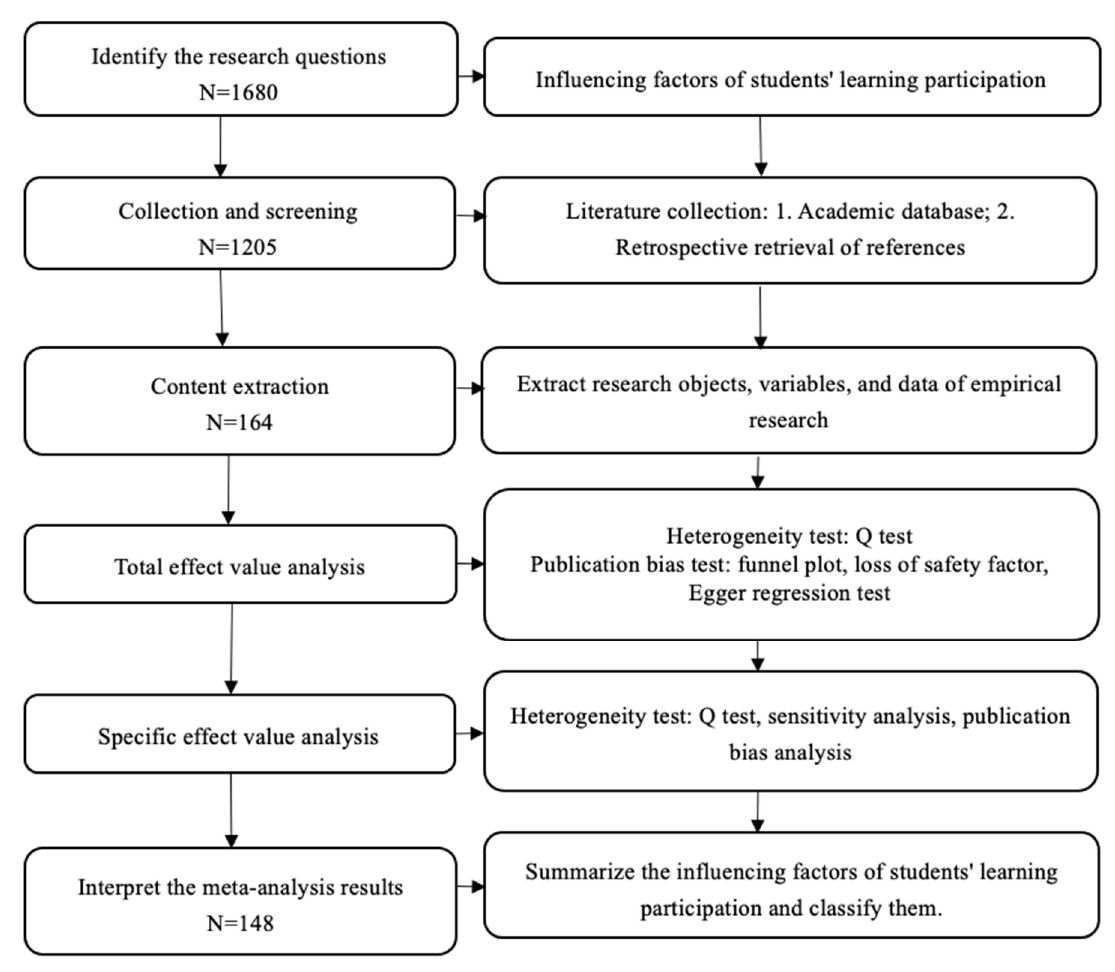
Figure 2. Preferred Reporting Items for Systematic Reviews and Meta-Analyses (PRISMA) flowchart used to identify studies for detailed analysis of student engagement and learning outcomes.